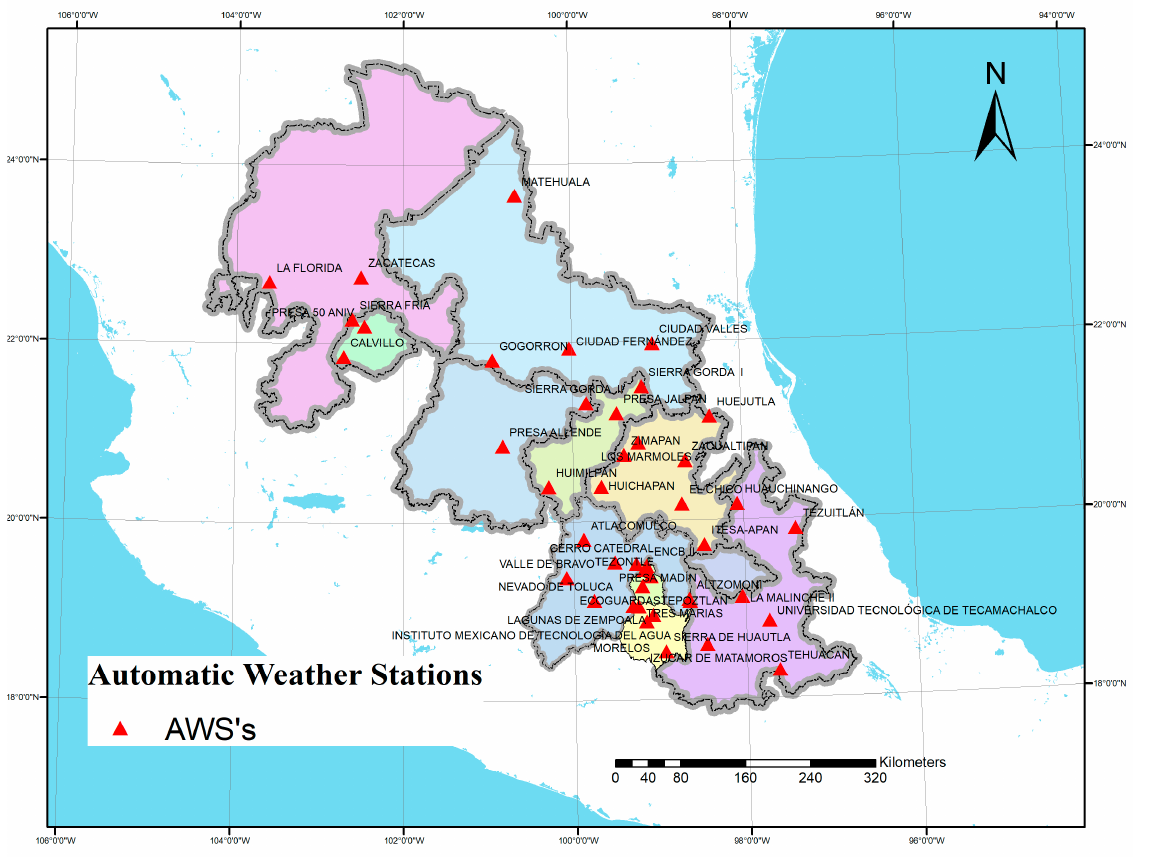
Figure 6. Automatic Weather Stations in Central Mexico.